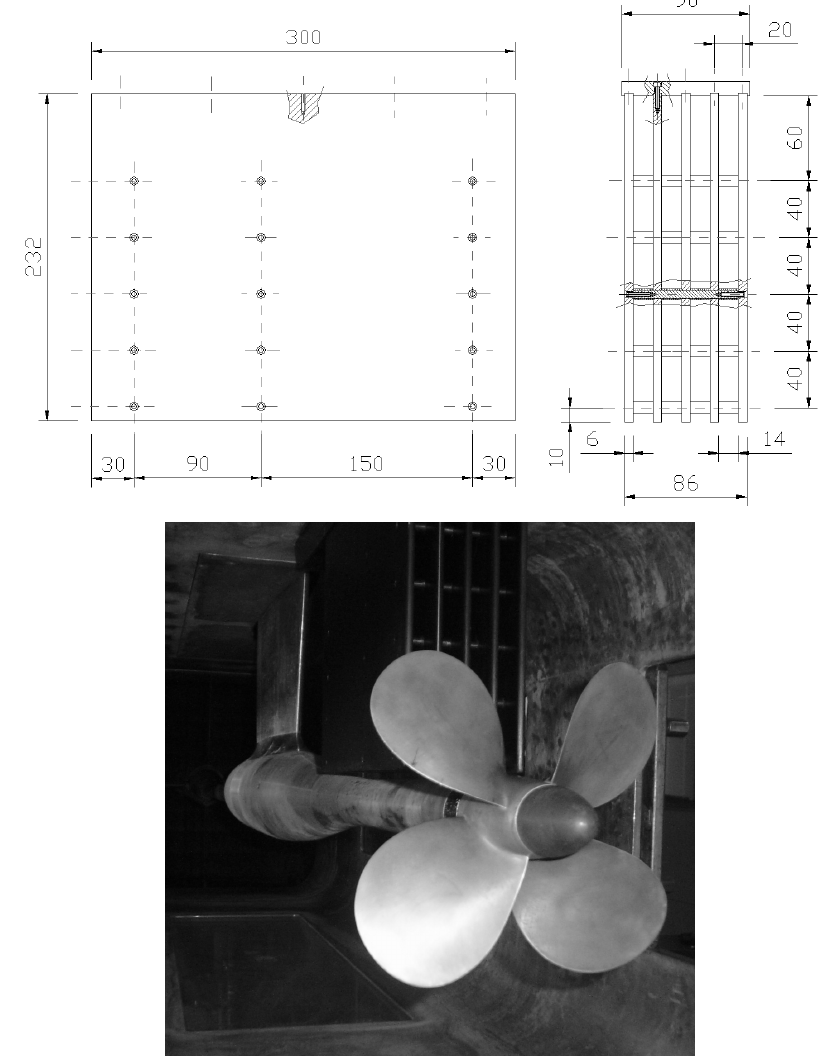
Figure 2. Non-uniform wake generator: design ( top ) and implementation in the cavitation tunnel ( bottom ). The dynamometer is mounted